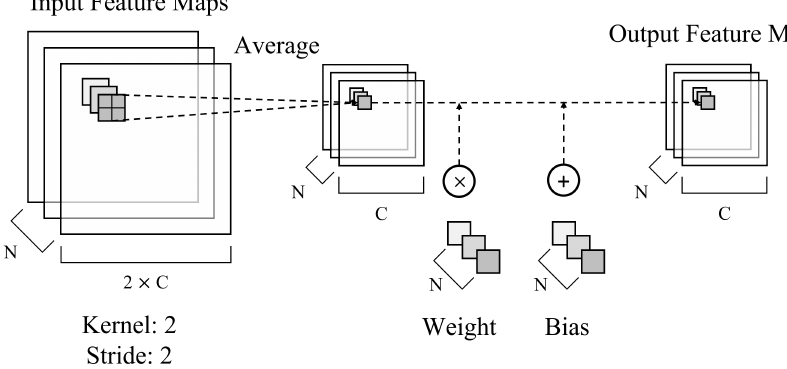
Figure 5. Average pooling with weights and